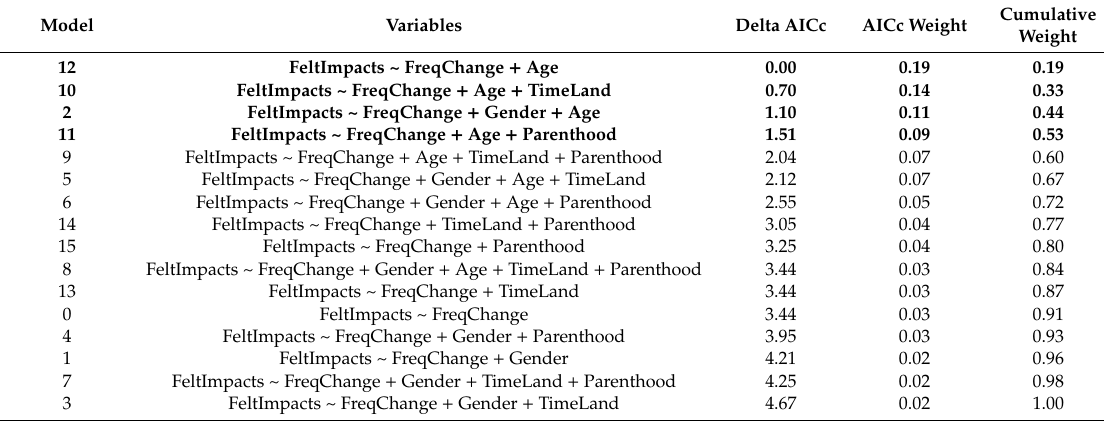
Table 3. Linear models determining the e ff ects of sociodemographic characteristics on felt impacts of perceived environmental changes. Retained models are shown in bold.